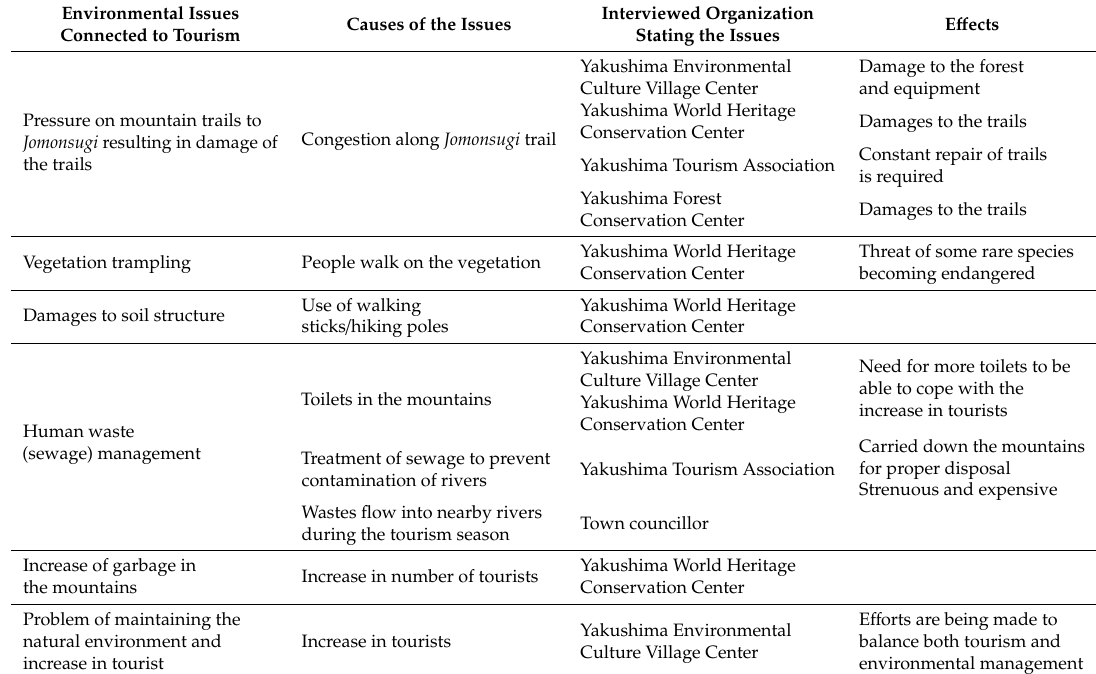
Table 3. Tourism related environmental issues in